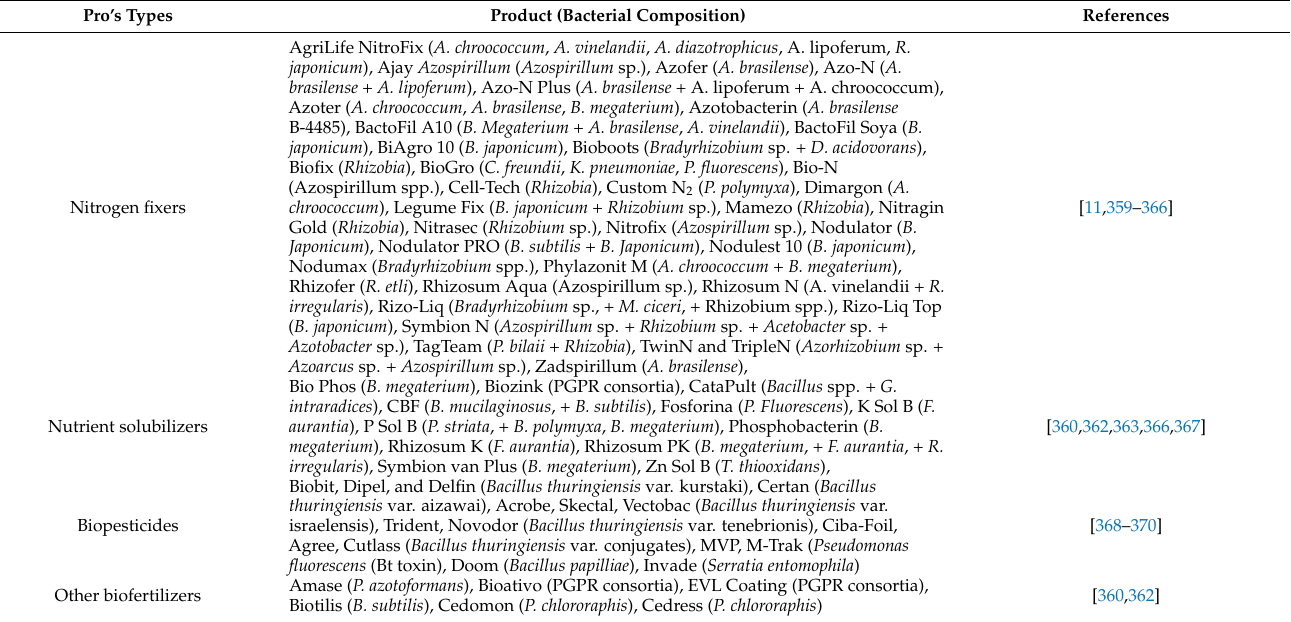
Table 5. Pros of biofertilizers and their